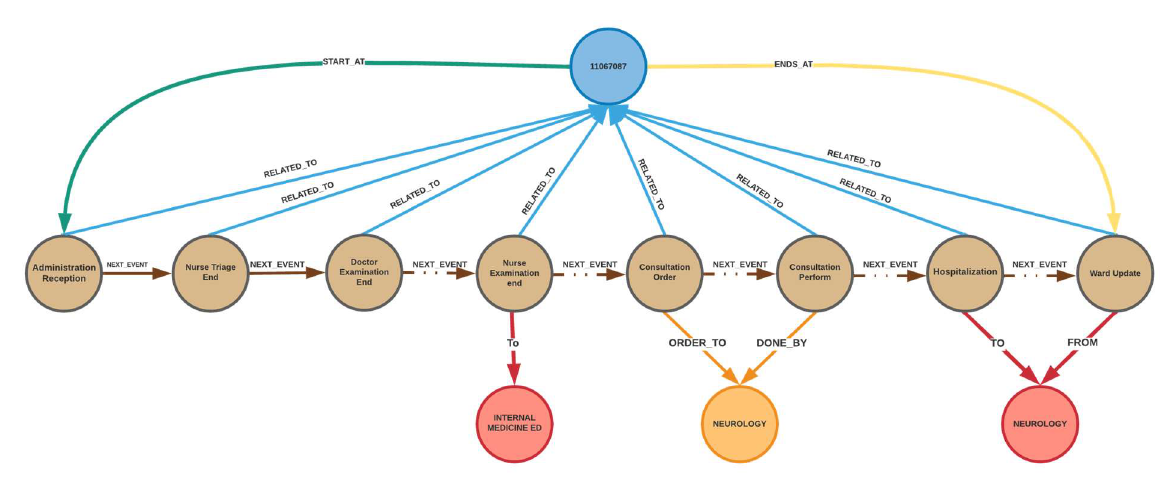
Figure 2. Example patient flow in ED for case number 11067087.